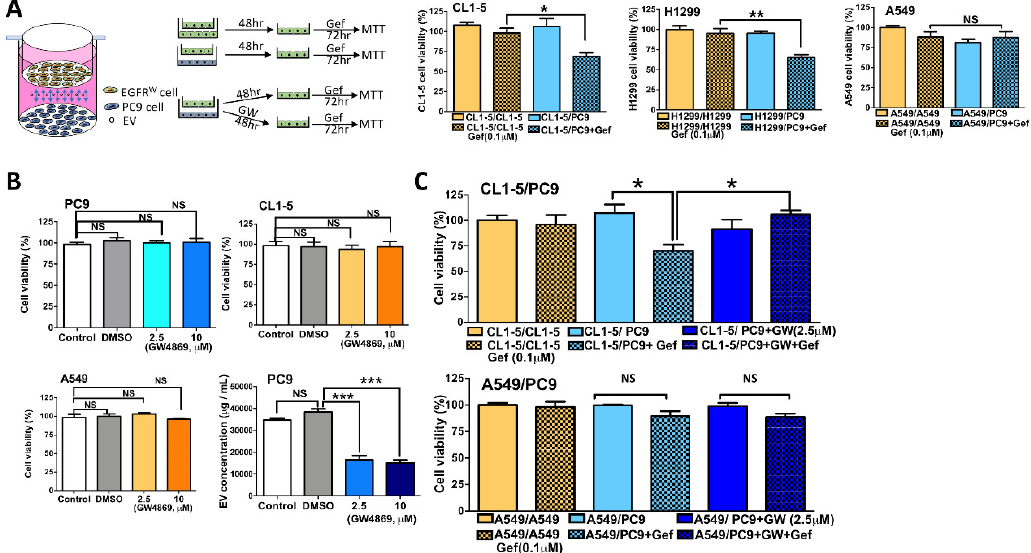
Figure 3. The sensitivity of EGFR wild-type cells increased in coculture with PC9 cells but decreased if PC9 cells were cocultured for 48 hours in a coculture system. ( A ) A schematic diagram illustrating the design of the coculture experiments. ( B ) EGFR wild-type cells were treated with gefitinib for 72 h after coculture with PC9 cells, and cell viability was examined by MTT assay. ( C ) The effect of GW4869 on cell viability was examined by MTT assay, and the effect of EVs was determined by ELISA by measuring total protein. ( D ) After adding GW4869 to the coculture system, EGFR wild-type cells were treated with gefitinib for 72 h, and cell viability was examined by MTT assay (* p < 0.05, ** p < 0.01, *** p < 0.005).